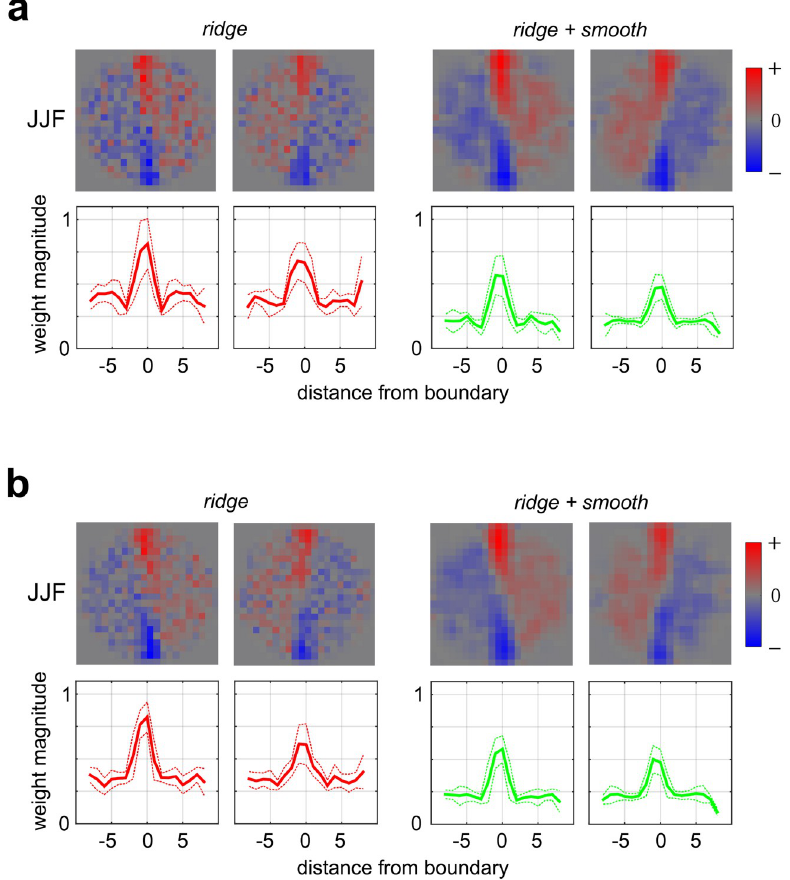
Fig 11. Second-stage filter weights for one representative observer, JJF, from Experiment 2 (orientation discrimination, Fig 1c, right). (a) Experiment 2-VAR. Top : Estimated 2-D weight maps averaged over 4 training folds. Bottom : 1-D profiles showing mean weight magnitude (thick lines), averaged over 30 bootstrapped re-samplings. Thin dashed lines show +/- 1 SEM. (b) Same as (a), but for Experiment 2-FIX.